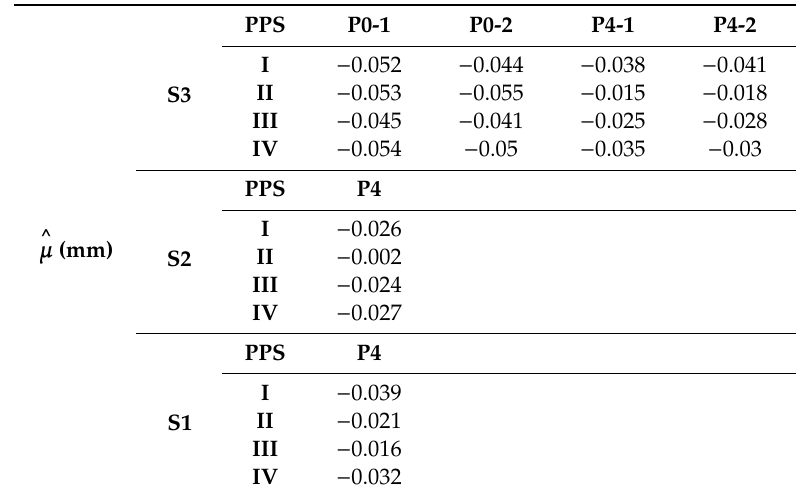
Table A4. Three-dimensional (3D) profile ( ) mean deviations (ˆ µ ) of Shape B artifacts at each post-processing step (as-built I, after stress relief II, after part removal III and after micro shot peening IV) .